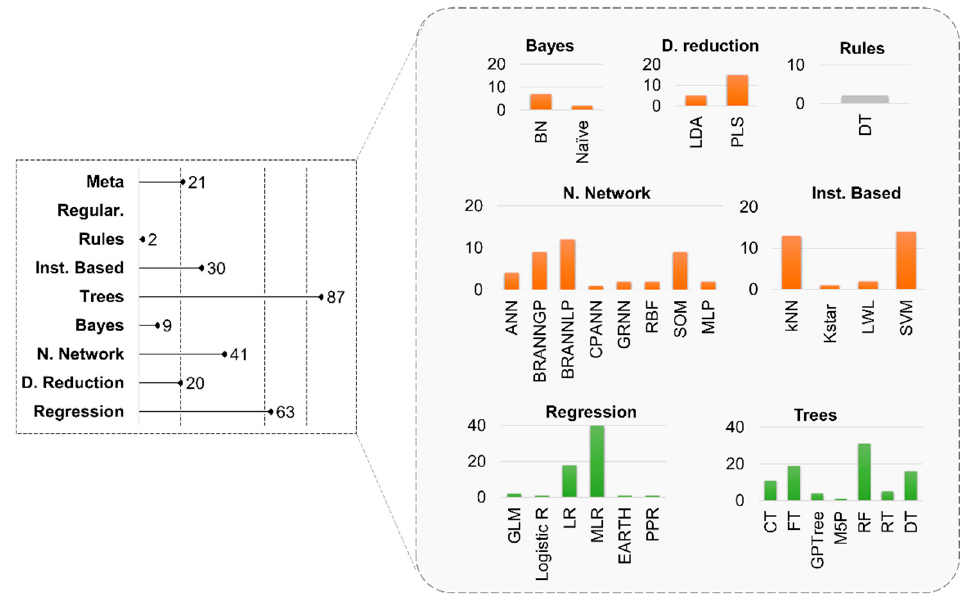
Figure 2. Model (cases) categories, their population (left), and detailed breakdown (right, zoomed box) as extracted from the 273 cases derived from the 86 studies gathered. Instance based (Inst Based), decision tress (D. Tree), Bayesian networks (Bayes), neural networks (N. Network), and dimensionality reduction algorithms (D. reduction).